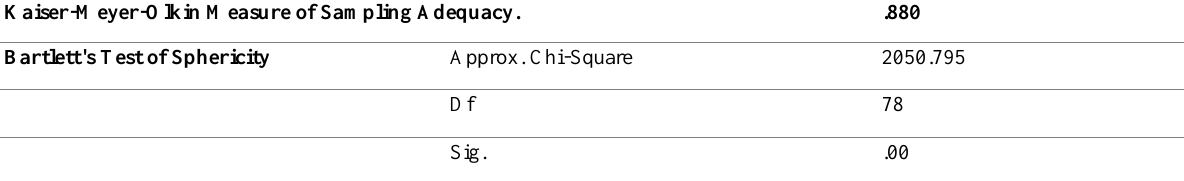
Table 1: KMO and Bartlett's test for intellectual capital